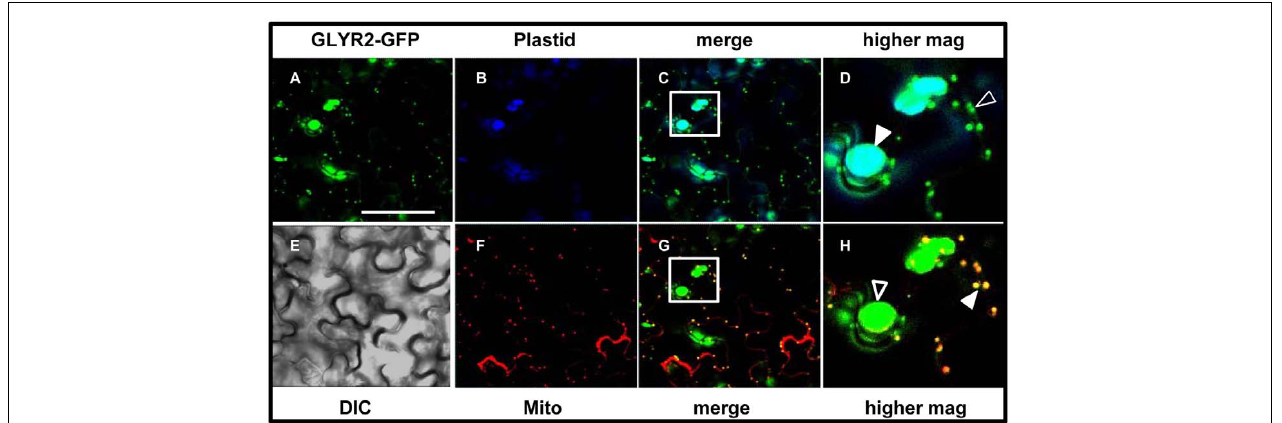
FIGURE 5 | Dual localization of methoxyfenozide-inducible AtGLYR2-GFP in stably transformed Arabidopsis. Arabidopsis seedlings, stably expressing AtGLYR2-GFP were imaged (by CLSM) after induction with methoxyfenozide (A) . (B,F) Represent the corresponding chlorophyll autofluorescence (plastid marker) and Mitotracker staining of the same cells, respectively. Co-localization of GFP and chlorophyll is observed based on the cyan color in the merged image in (C) and co-localization of GFP and Mitotracker is observed based on the yellow color in the merged image in (G) . Boxes correspond to the regions of the cell shown at higher magnification in panels (D,H) ; solid arrowheads indicate obvious examples of co-localizations, whereas open arrowheads indicate obvious examples of non-co-localization. (E) The corresponding differential interference contrast image. Scale bar = 30 µ m.